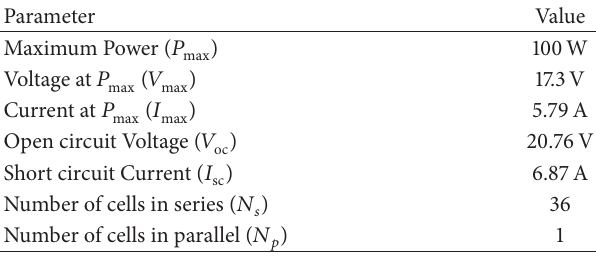
Table 1: Simulation model parameters of ICO-SPC 100W photo- voltaic module [3].